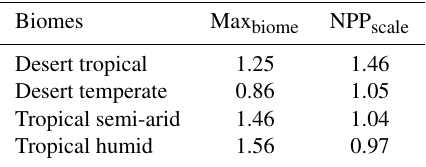
Table A4. Parameter values of the synergistic function in Eq. (A4).